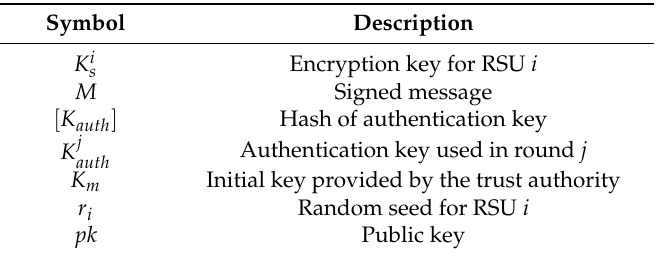
Table 1. Notation